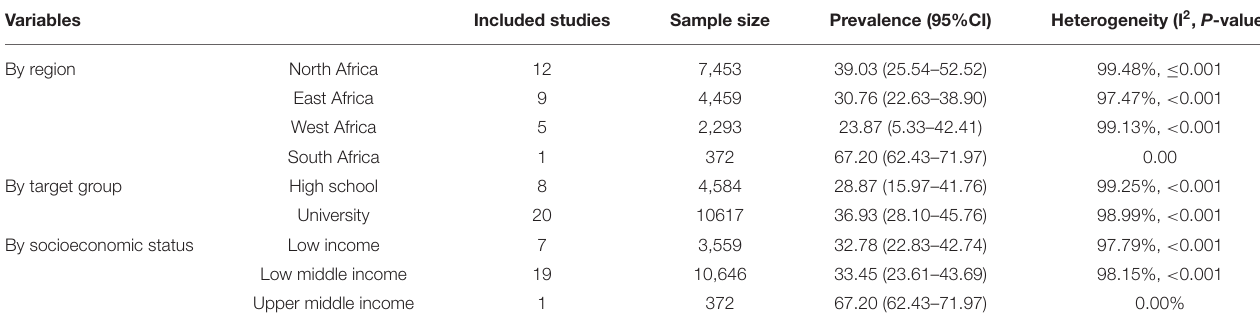
TABLE 2 | Sub-group analysis for internet addiction and its associated factors among students in Africa. Variables